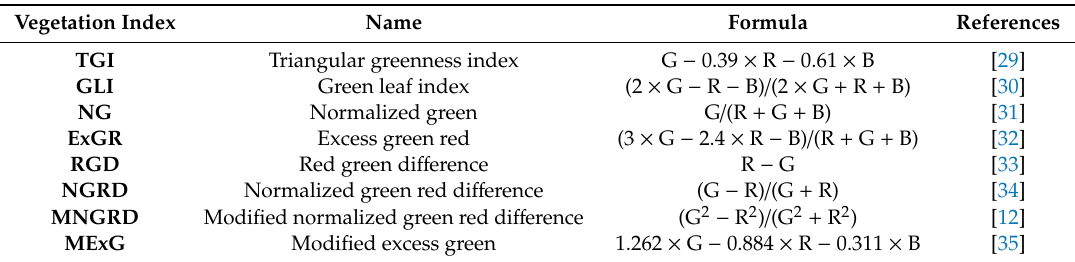
Table 3. Vegetation indices (VIs) used as predictors for the machine learning model (MLM). G—mean value of the GREEN channel, R—mean value of the RED channel, and B—mean value of the BLUE channel.